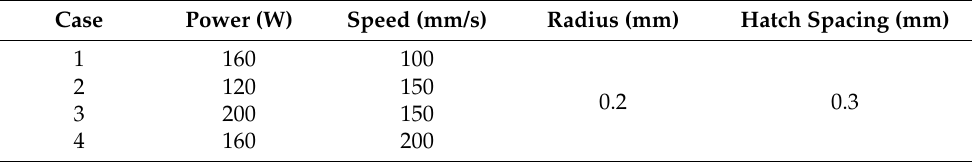
Table 2. Process parameter